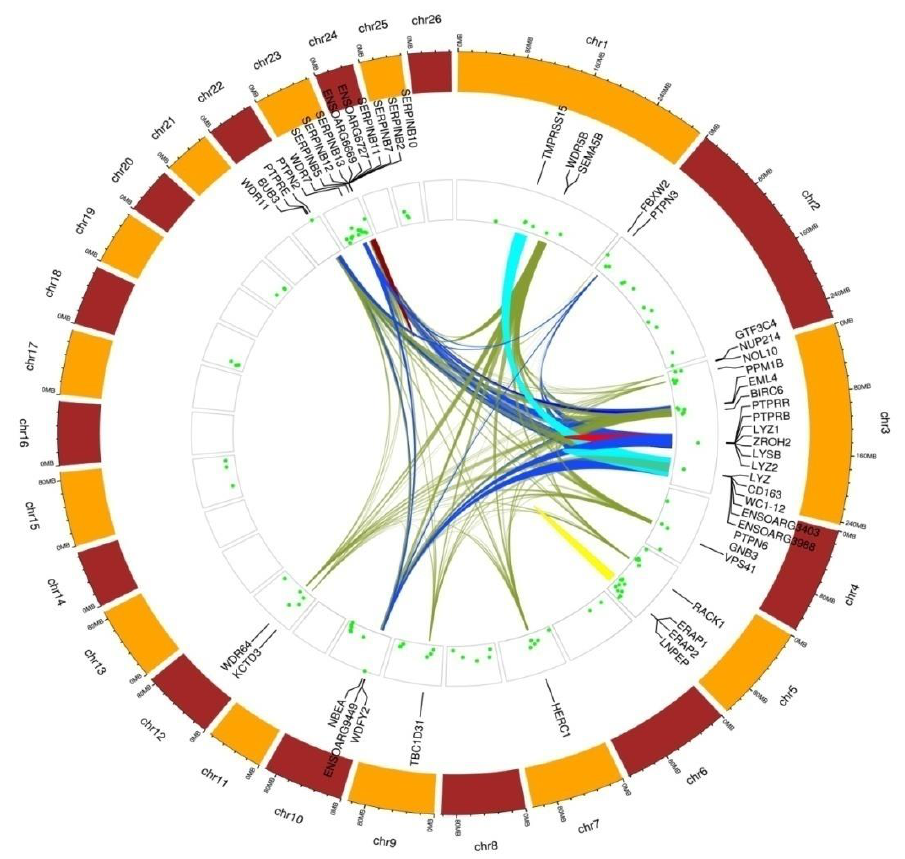
Figure 5. Circular map summarizing information on functional clusters identified in Djallonké sheep. Chromosomes are shown in the outermost circle. The innermost circles show the distribution of the candidate genomic areas identified within a chromosome. Differences in height among candidate areas inform on the number of SNPs defining them. Candidate genes forming the significantly enriched functional term clusters are indicated beside their genomic localization. At the center of the map, links among candidate genes belonging to the same functional cluster are illustrated using the same color (cluster 1 in brown on OAR23; cluster 2 in red on OAR3; cluster 3 in dark blue; cluster 4 in light blue; cluster 5 in green; cluster 6 in yellow on OAR5).